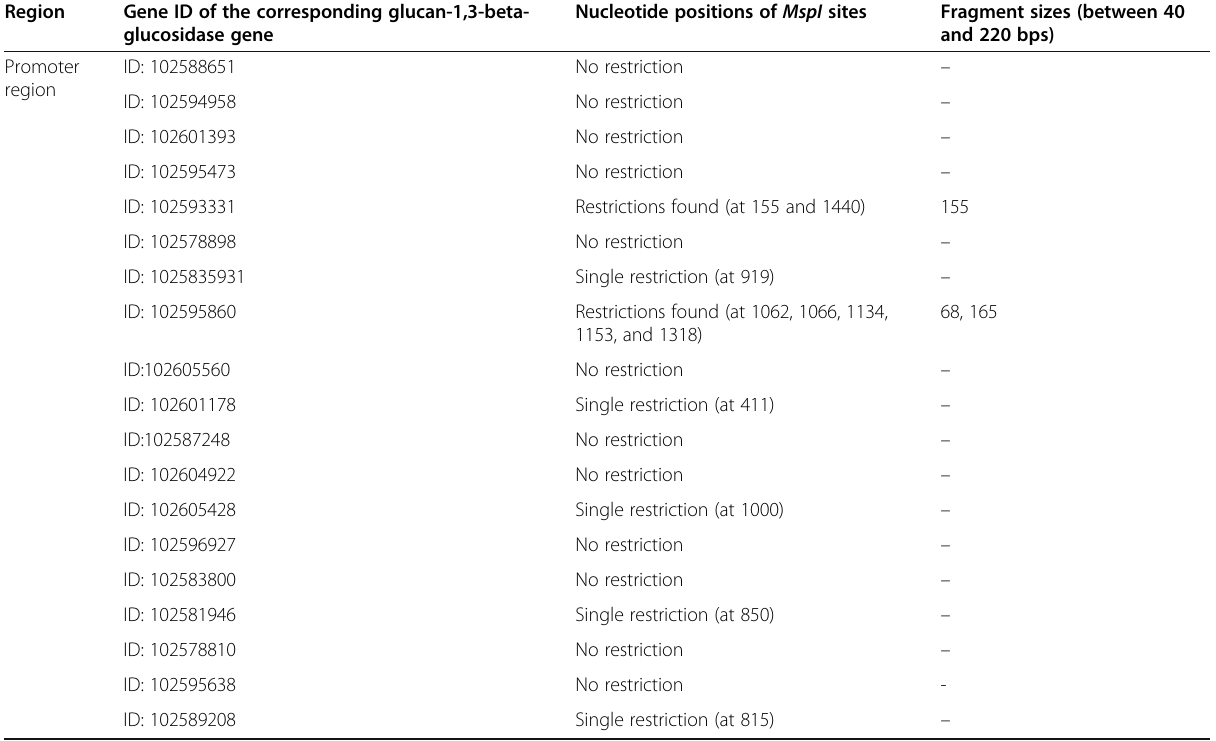
Table 5 MspI cutting sites and fragment sizes for glucan endo -1,3-beta-glucosidase genes in the promoter regions Region Gene ID of the corresponding glucan-1,3-beta- glucosidase